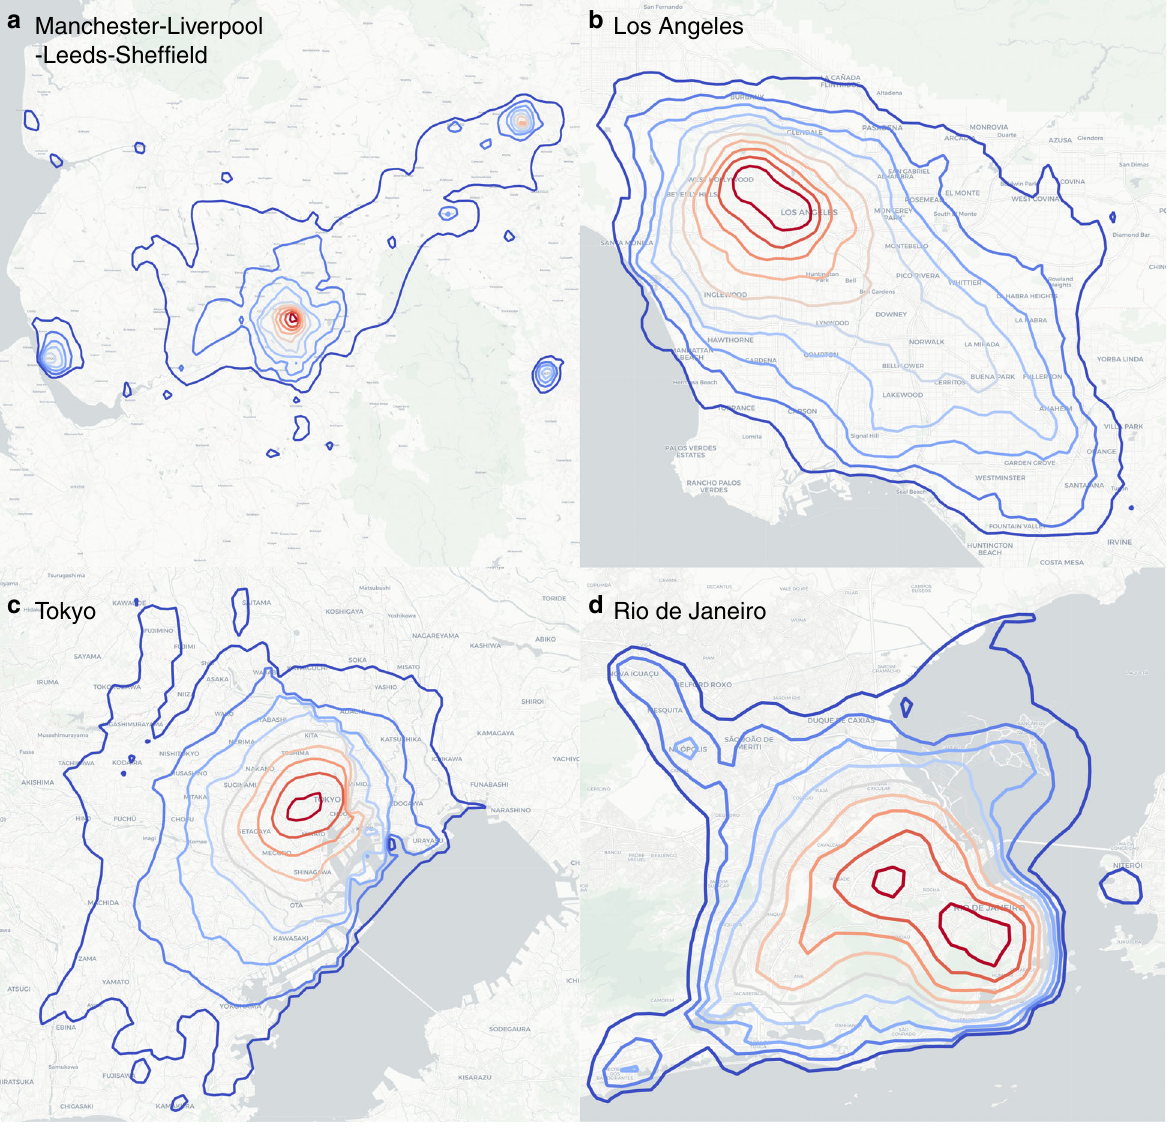
Fig. 7 Empirical equipotential curves. Equipotential curves calculated with commuting fl ows obtained from Twitter data for several world cities and conurbations. a Manchester – Liverpool – Leeds – Shef fi eld (UK), b Los Angeles (USA), c Tokyo (Japan), and d Rio de Janeiro (Brazil). The underground map layout is produced using Carto. Map tiles by Carto, under CC BY 3.0. Data by OpenStreetMap, under